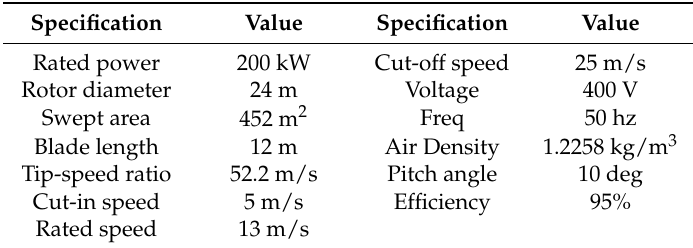
Table 3. Specification of MICON